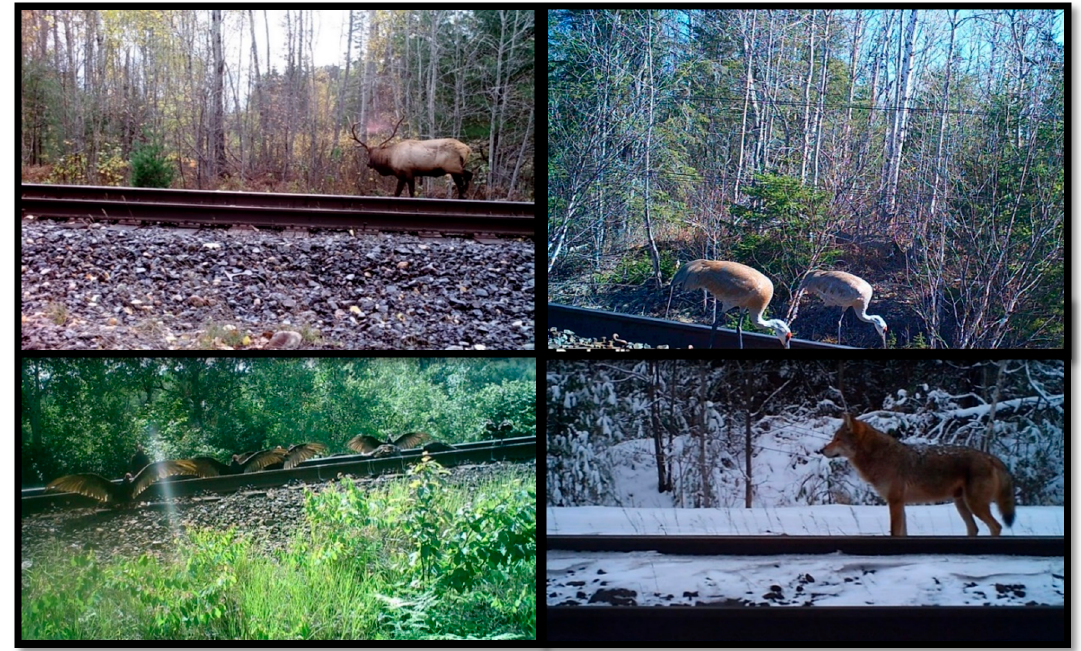
Figure 2. Some of the birds and mammals captured by cameras along 20 km of the studied railway from 2015 to 2016 (clockwise from top-left: elk, sandhill cranes, wolf, turkey vultures).